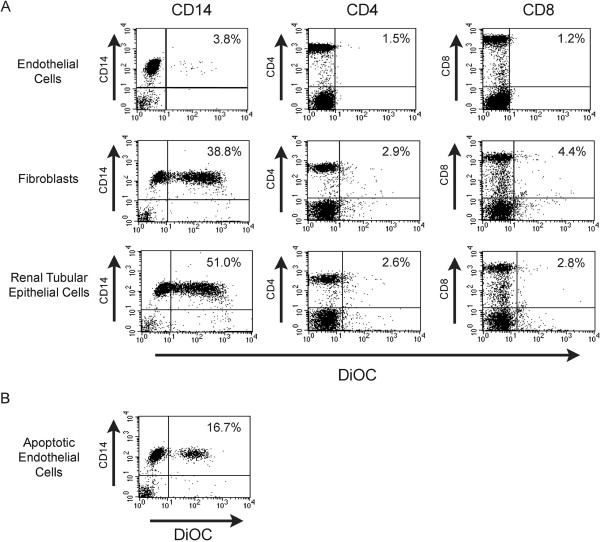
Transfer of the dye from EC, fibroblasts or RPTEC to CD14+monocytes in transmigration assays. Confluent monolayers of EC, fibroblasts and RPTEC were grown on transwell inserts and labeled with the lipophylic dye, DiOC-16. Labeled cells were washed extensively before each experiment. A total of 1x106 PBMC were placed into the upper chamber of the transwell, were allowed to transmigrate into the lower chamber and were collected after 1.5h. Panel A, DiOC uptake was assessed by FACS analysis on CD14+ monocytes and on CD4+ or CD8+ T cells following transmigration. Panel B, Uptake of DiOC was assessed on CD14+ monocytes following interactions with EC undergoing apoptosis. Apoptosis was induced in EC by TNF- and cyclohexamide treatment. The percent double positive cells is shown in the right upper corner of each panel. Results are representative of 10 experiments for each cell type, and was identical when different PBMCs and cell lines were used